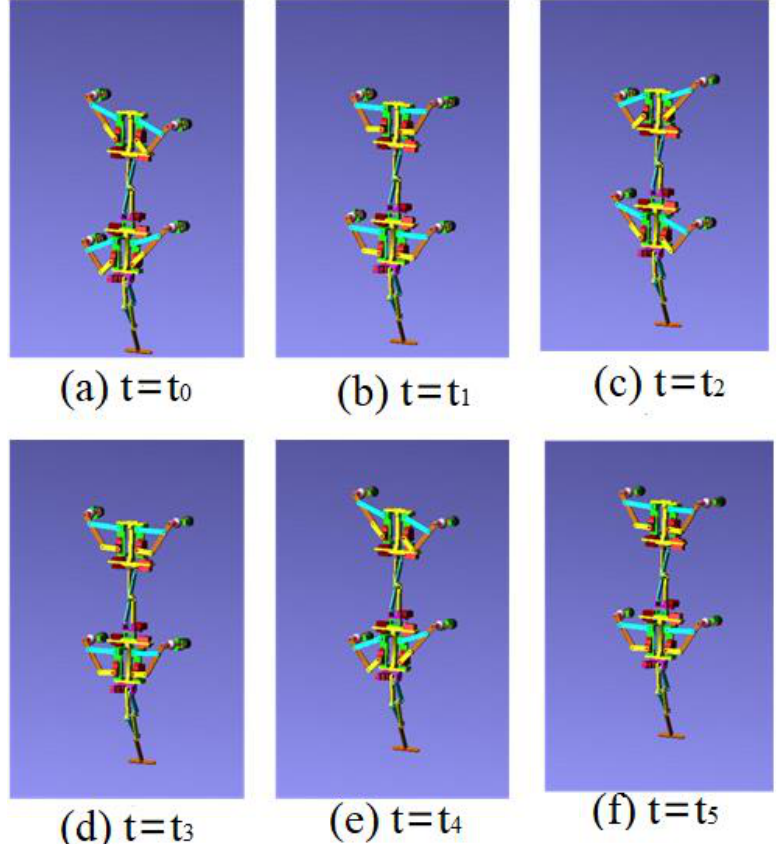
Figure 6. Diagonal gait for walking straight forward in ADAMS in different moments.